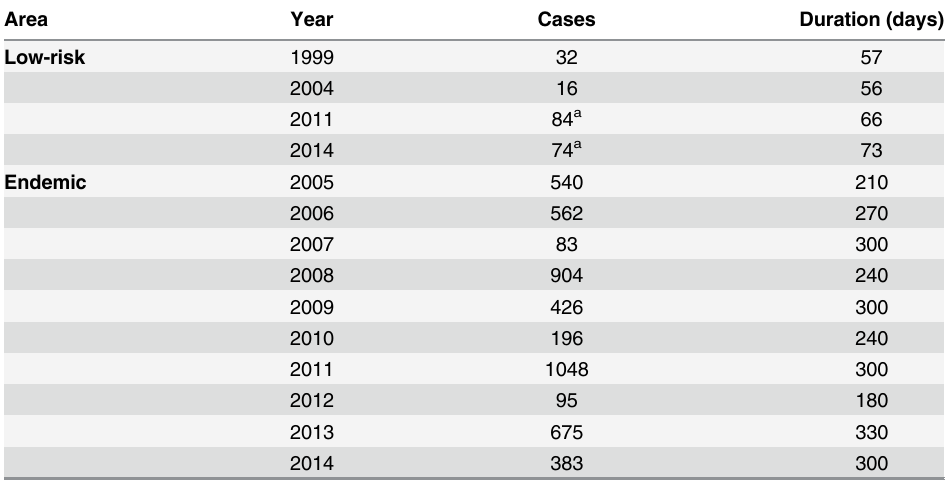
Table 4. Numbers of reported cases by outbreak and outbreak duration for the low-risk area and by AHS season (year) for the endemic